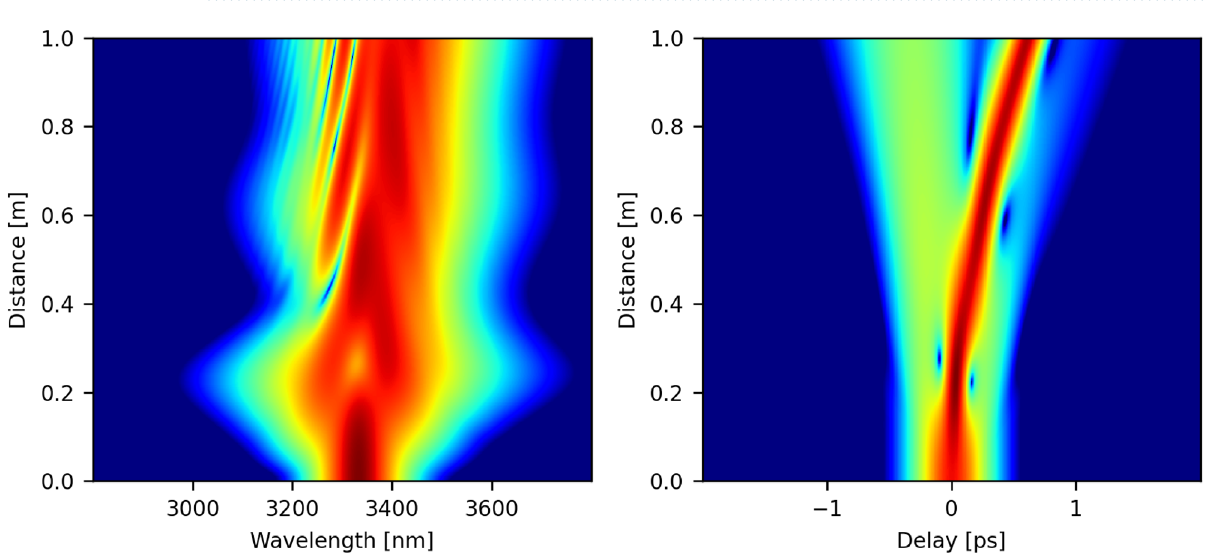
Figure 11. Propagation of the main soliton in the case P out = 170 mW (Fig.10b) within the first meter of the InF 3